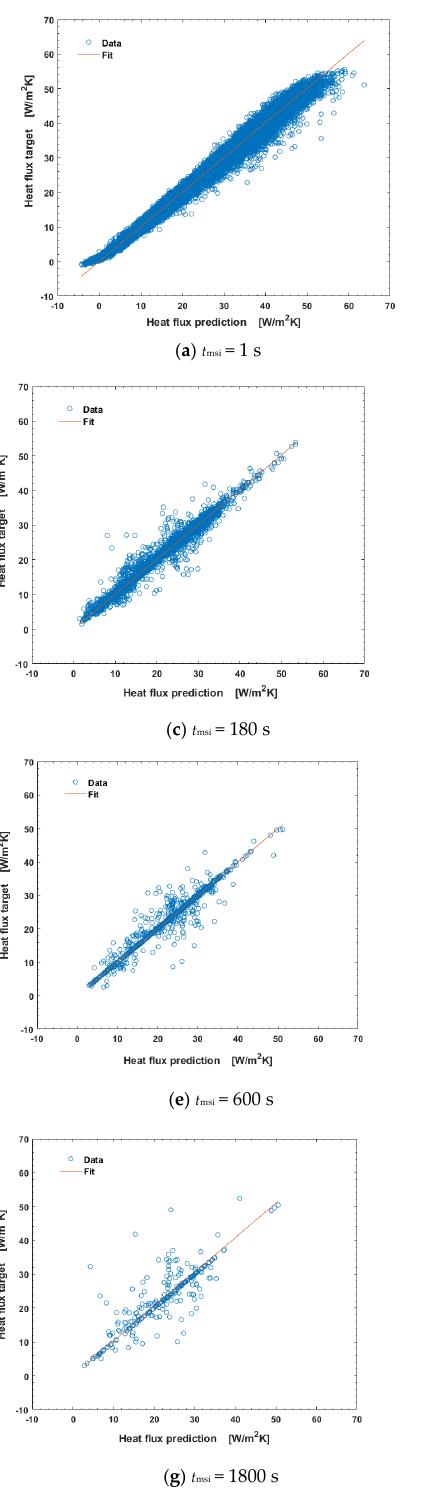
Figure 7. Evaluation of regression graph for all data using LSTM model.